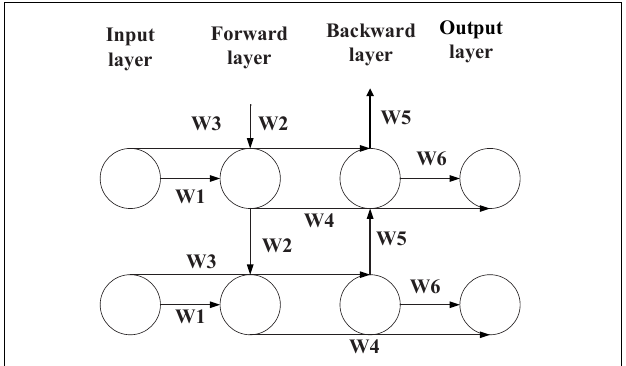
FIGURE 4 | Bidirectional LSTM